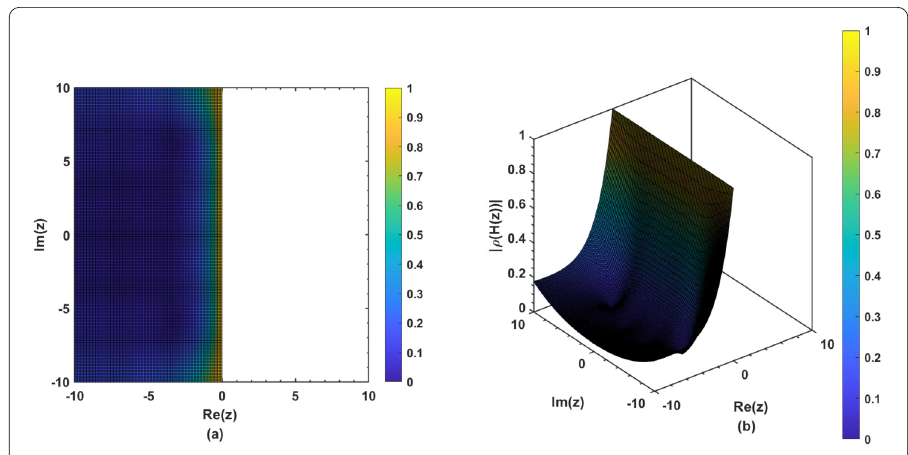
Figure 1 The stability region in 2D and 3D of the proposed one-step block method (16) with three intrastep points, including one optimal